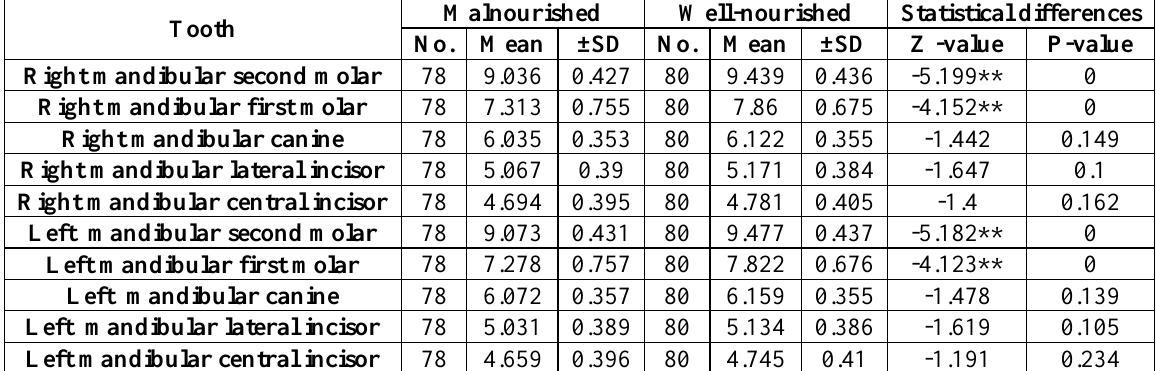
Table 4: Measurement of bucco-lingual diameters (mm) of mandibular teeth in malnourished and well-nourished group among children aged 5 years by gender. Malnourished Well-nourished Statistical differences Tooth No. Mean ±SD No. Mean ±SD Z -value P-value Right mandibular second molar 78 Right mandibular lateral incisor Right mandibular central incisor Left mandibular first molar Left mandibular